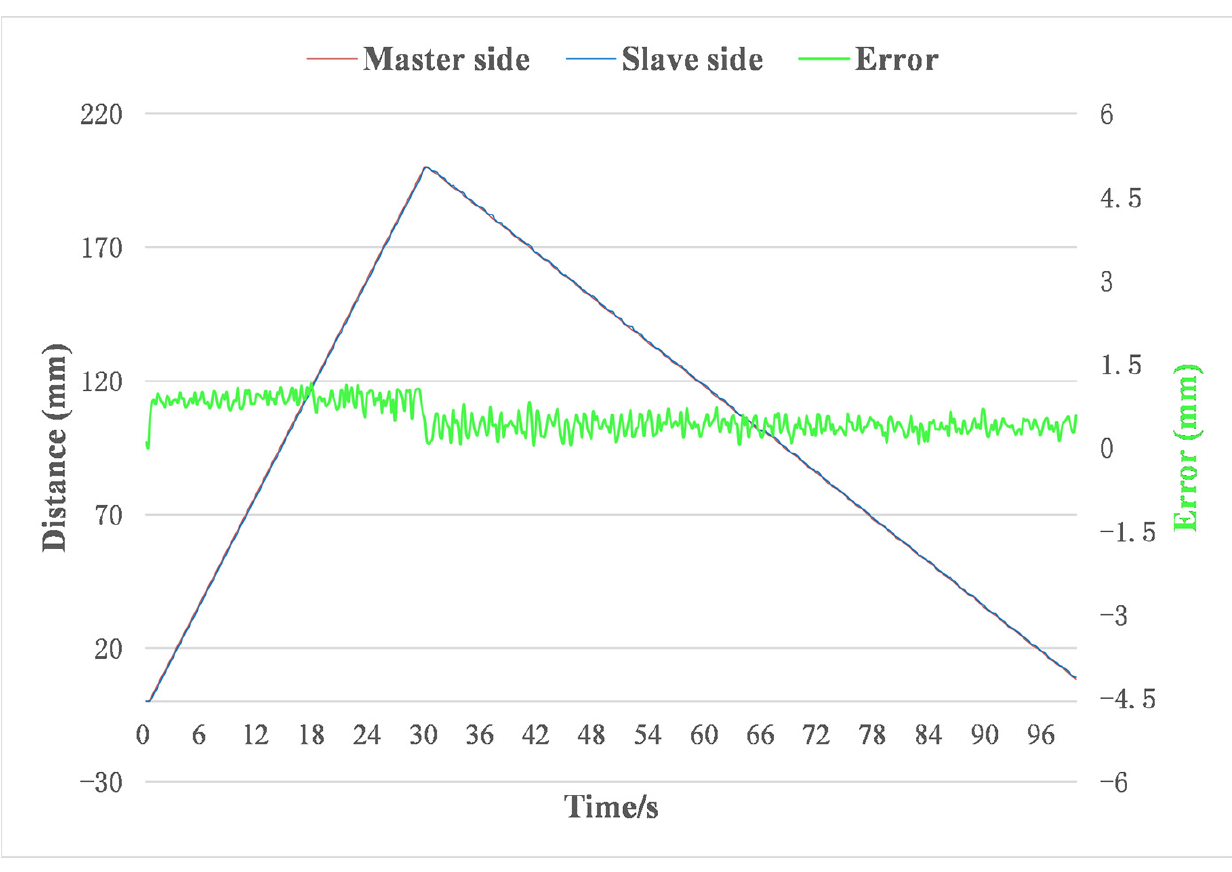
Figure 14. Result for the linear tracking in the experiment.